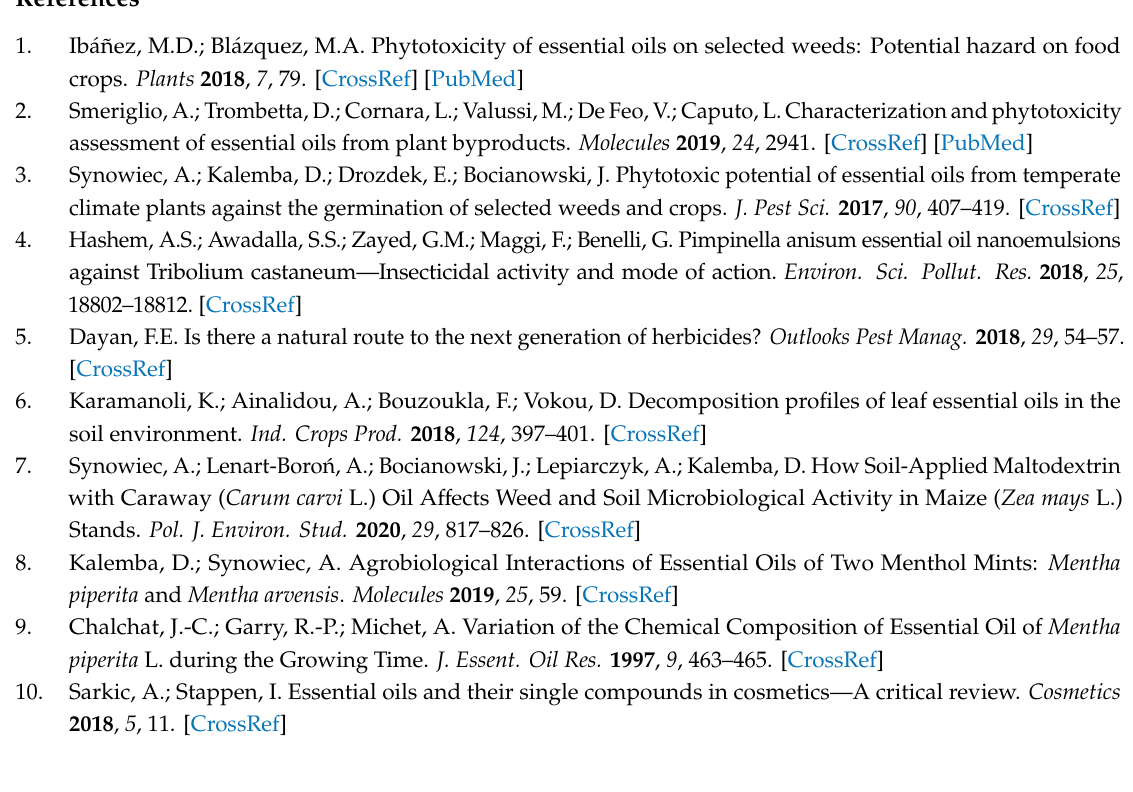
Table S6: Mean values ( ± standard deviation) for root dry weight of maize cultivars growing in the three di ff erent growth substrates amended with five doses of microencapsulated peppermint oil (g m − 2 ) and control (0 g m − 2 ), Table S7: Mean values ( ± standard deviation) for shoot dry weight of maize cultivars growing in the three di ff erent growth substrates amended with five doses of microencapsulated peppermint oil (g m − 2 ) and control (0 g m − 2 ), Table S8: Mean values ( ± standard deviation) for specific leaf weight of maize cultivars growing in the three di ff erent growth substrates amended with five doses of microencapsulated peppermint oil (g m − 2 ) and control (0 g m − 2 ), Table S9: Mean values ( ± standard deviation) for the content of phenolic compounds in the second leaf of maize cultivars growing in the three di ff erent growth substrates amended with five doses of microencapsulated peppermint oil (g m − 2 ) and control (0 g m − 2 ), Table S10: Mean values ( ± standard deviation) for the content of phenolic compounds in the roots of maize cultivars growing in the three di ff erent growth substrates amended with five doses of microencapsulated peppermint oil (g m − 2 ) and control (0 g m − 2 ), Table S11: Correlation coe ffi cients between the first two canonical variables and original parameters, Table S12: Mean squares from three-way analysis of variance for seven quantitative parameters of maize treated with maltodextrin only, Table S13: Mean values ( ± standard deviation) for root length of maize cultivars growing in the three di ff erent growth substrates amended with maltodextrin (g m − 2 ), Table S14: Mean values ( ± standard deviation) for root dry weight of maize cultivars growing in the three di ff erent growth substrates amended with maltodextrin (g m − 2 ), Table S15: Mean values ( ± standard deviation) for phenolics content in roots of maize cultivars growing in the three di ff erent growth substrates amended with maltodextrin (g m − 2